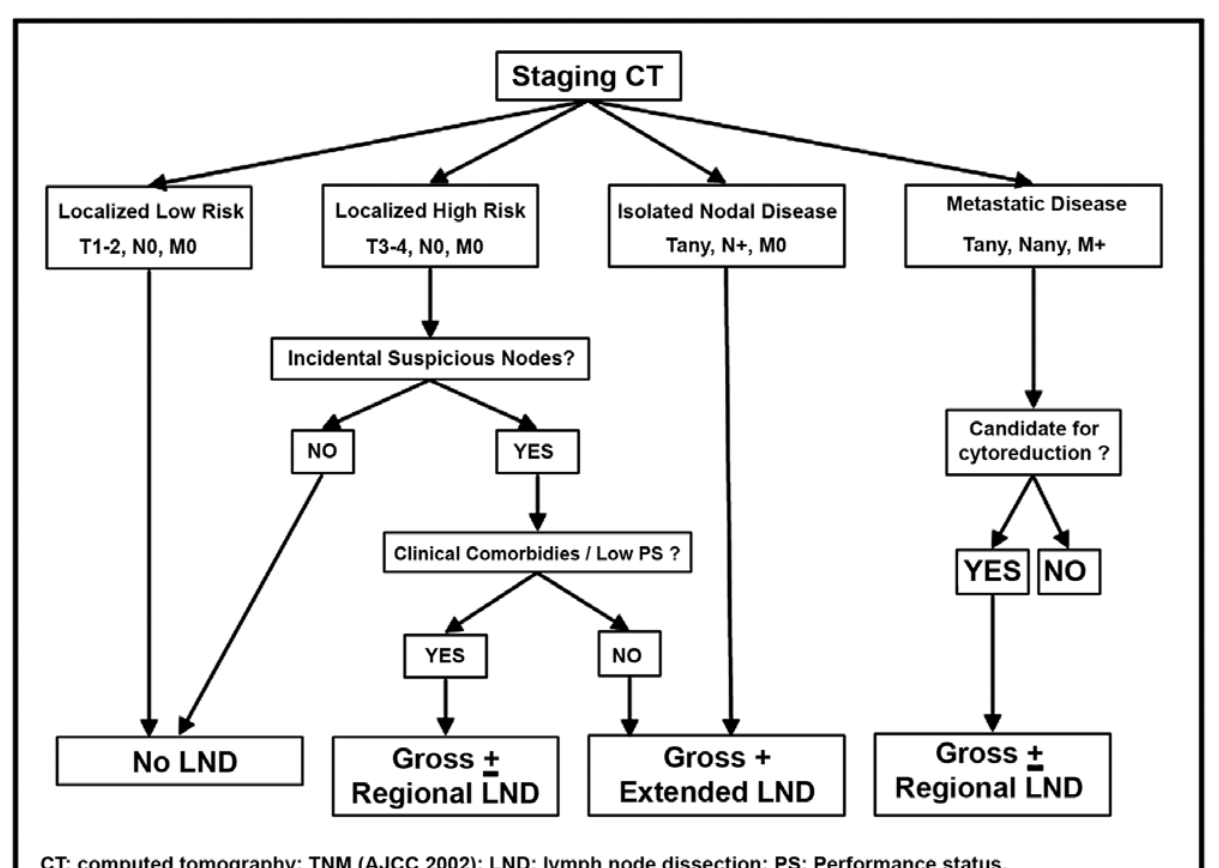
Figure 1 – Lymph node dissection during radical nephrectomy